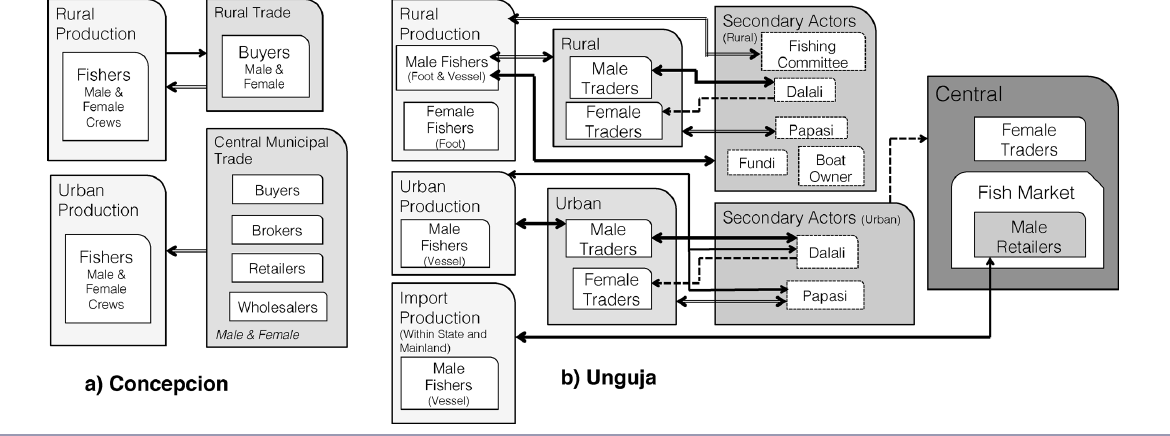
Fig. 6 . Assistance exchange network in Concepcion (a) and Unguja (b). This figure schematically illustrates the networks through which assistance, in the form of material, i.e., fishing gear, vessels, money, fish, and food, and/ or services, processing help, transport help, assistance at sea, vessel aid, etc., were exchanged between nodes. Dashed lines represent flows of assistance received or provided by women, while bold lines represent male exchanges. Double line arrows represents both genders. Fundi refers to the men who fix boats and nets and other fishing gear or